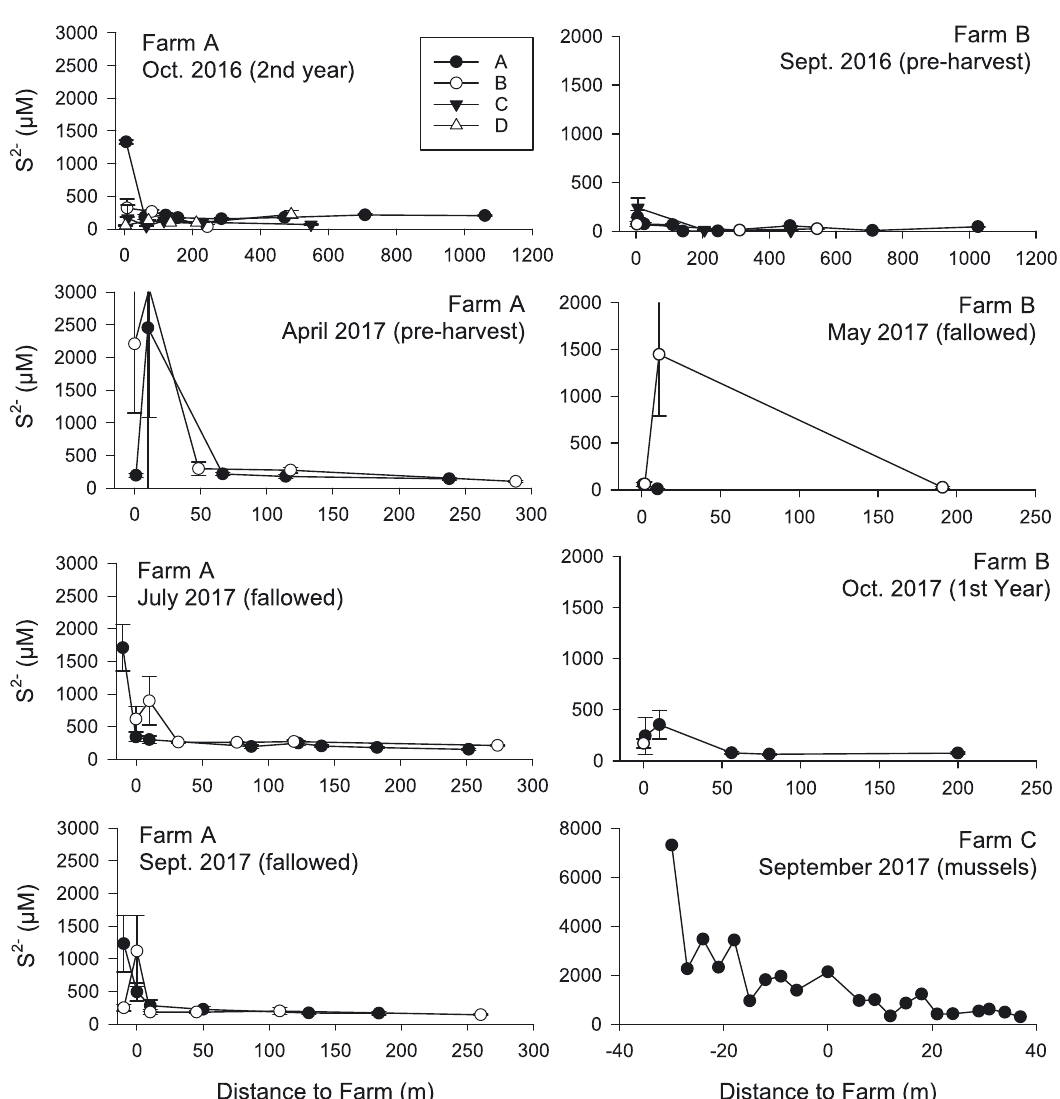
Fig. 5. Sediment total free sulfide (S 2− UV ; mean ± SE) concentrations at Farm A, Farm B, and Farm C relative to distance from farm during different seasons and husbandry stages. Letters in the legend refer to sampling transects (A: predominant cur- rent direction; B: opposite direction; C and D: orthogonal directions). Note different distance scales and negative distances for stations inside the